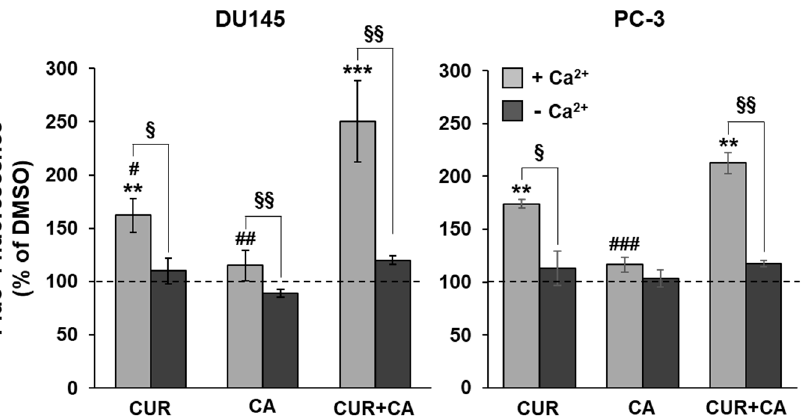
Figure 5. The combination of polyphenols induces elevation of cytosolic calcium levels in prostate cancer cells. Fluo-4 emission was recorded kinetically at 1 min intervals, starting immediately upon the addition of 7 µM CUR, 5 µM CA or their combination (CUR + CA). The bars show peak [Ca 2+ ] cyt signals recorded at 6–8 min (as in Supplementary Figure S3) relative to DMSO-treated cells. Data are presented as mean ± SEM ( n = 3). Statistically significant differences for CUR, CA or CUR + CA vs. DMSO (** p < 0.01 and *** p < 0.001) and for CUR and CA vs. CUR + CA (# p < 0.05; ## p < 0.01 and ### p < 0.001). § p < 0.05 and §§ p < 0.01, significant difference between the two indicated groups (Student’s t -test).